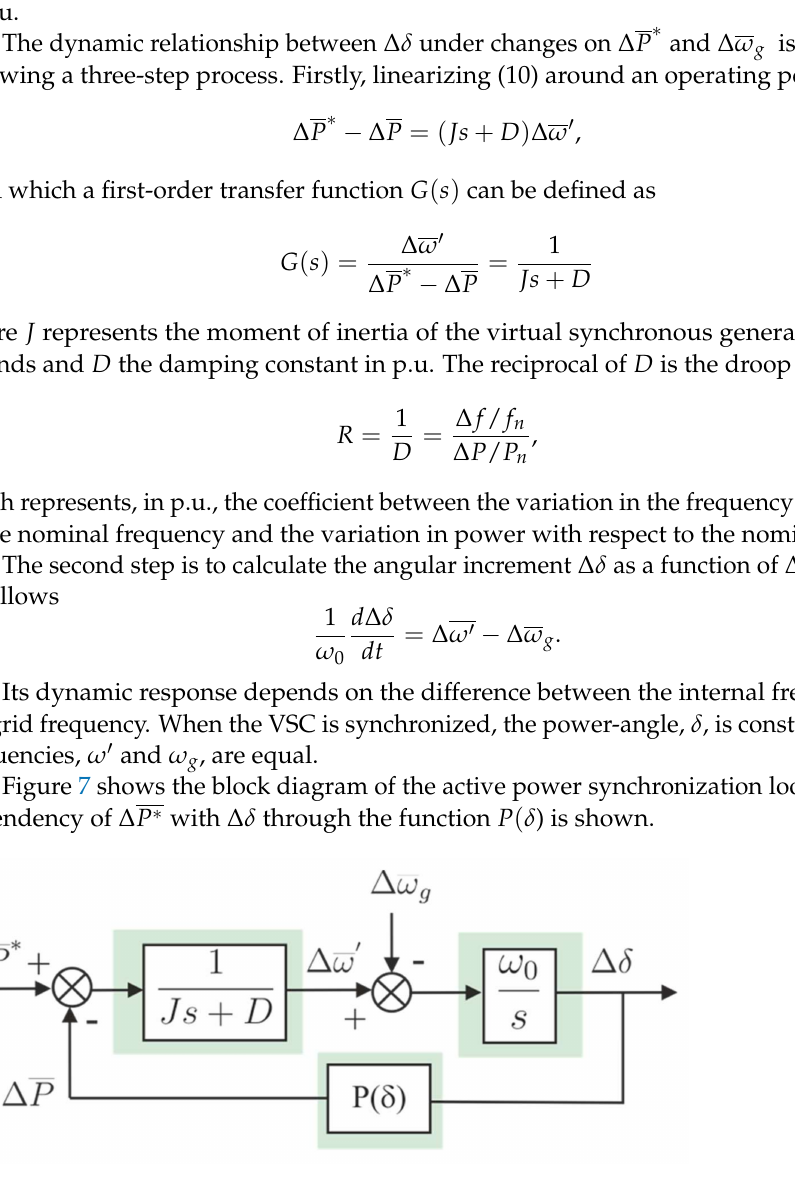
Figure 7. Block diagram of the active power synchronization